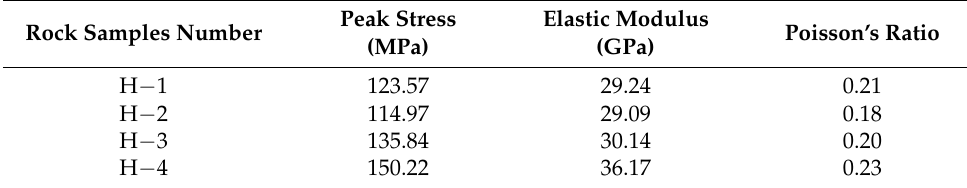
Table 1. Uniaxial compression test results.